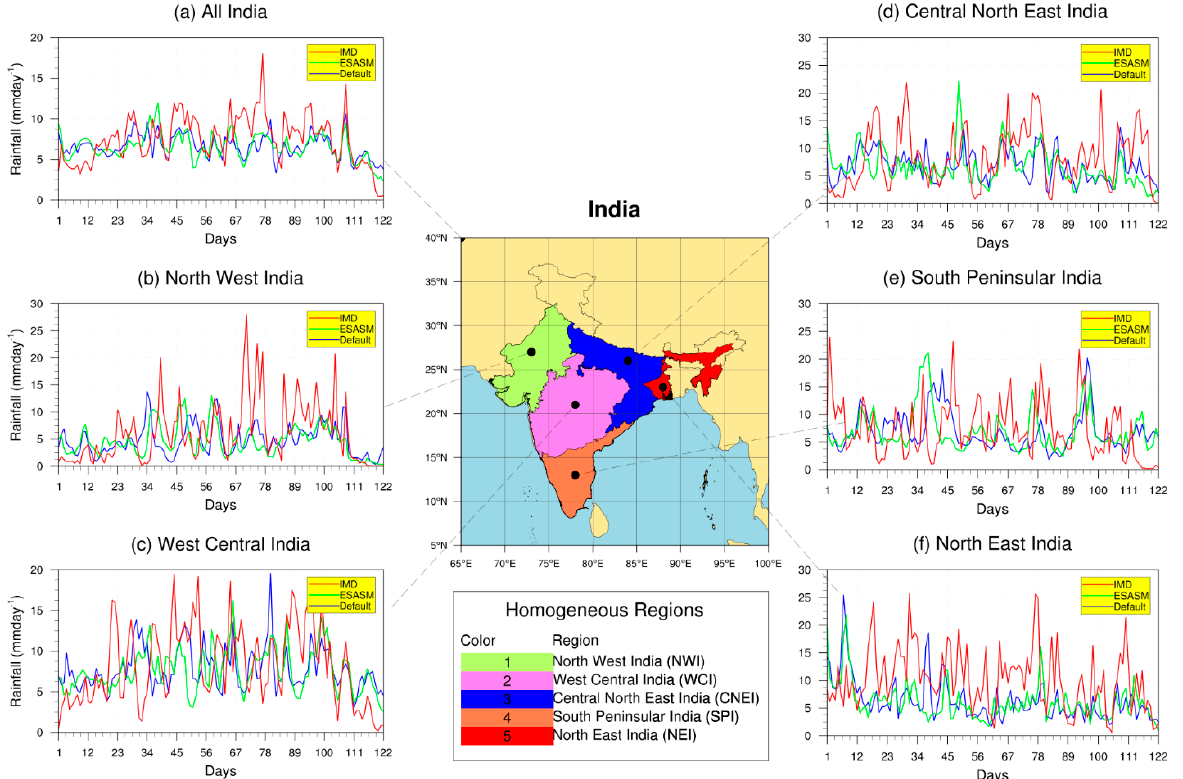
Figure 11. Same as Figure 10, but for the year 2011.